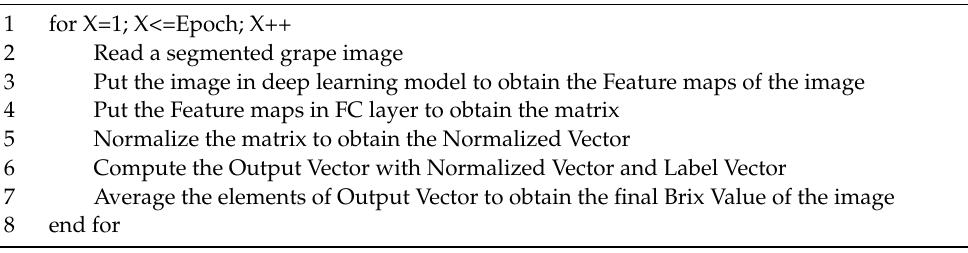
Algorithm 1. Feature normalization reweighting regression model training